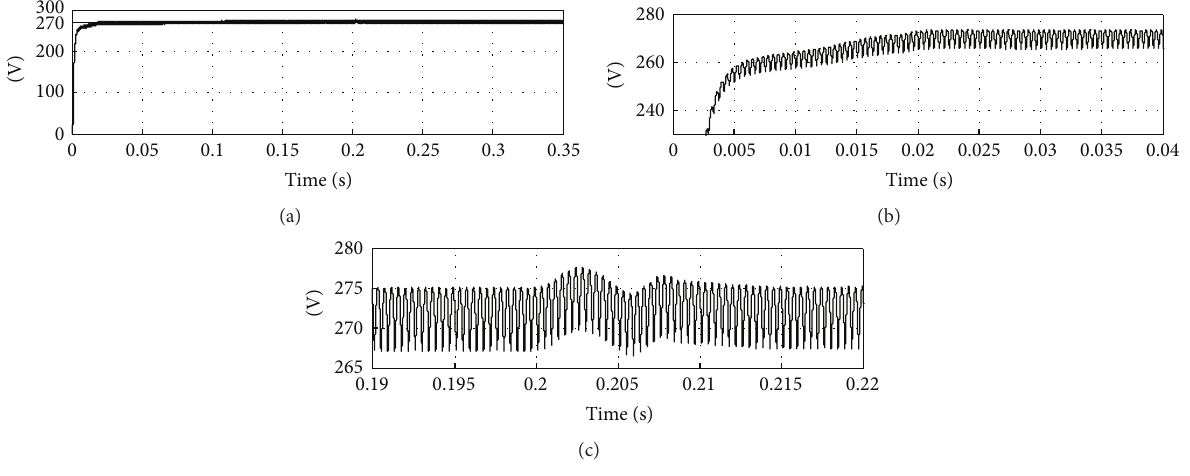
Figure 6: Simulation of transformer rectifier module.